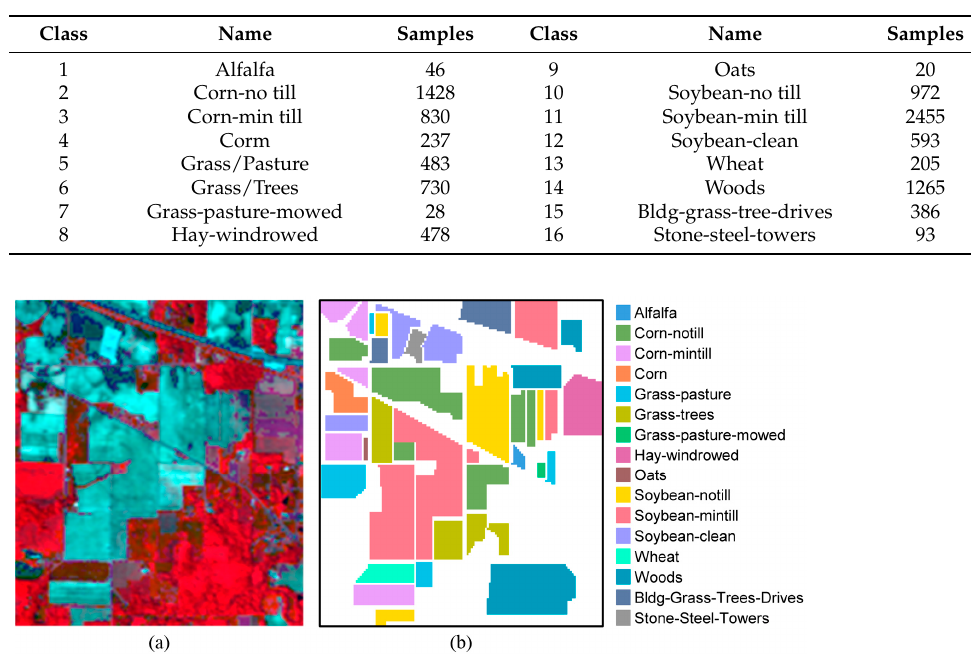
Figure 2. ( a ) False ‐ color image and ( b ) ground truth map of the Indian Pines data set.